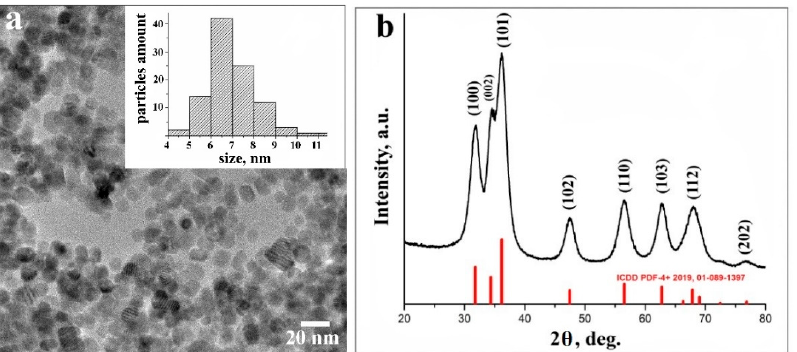
Figure 1. High-resolution transmission electron microscopy (HRTEM) image of ZnO nanoparticles (NPs), with particles size distribution (inset) ( a ); XRD data of ZnO NPs ( b